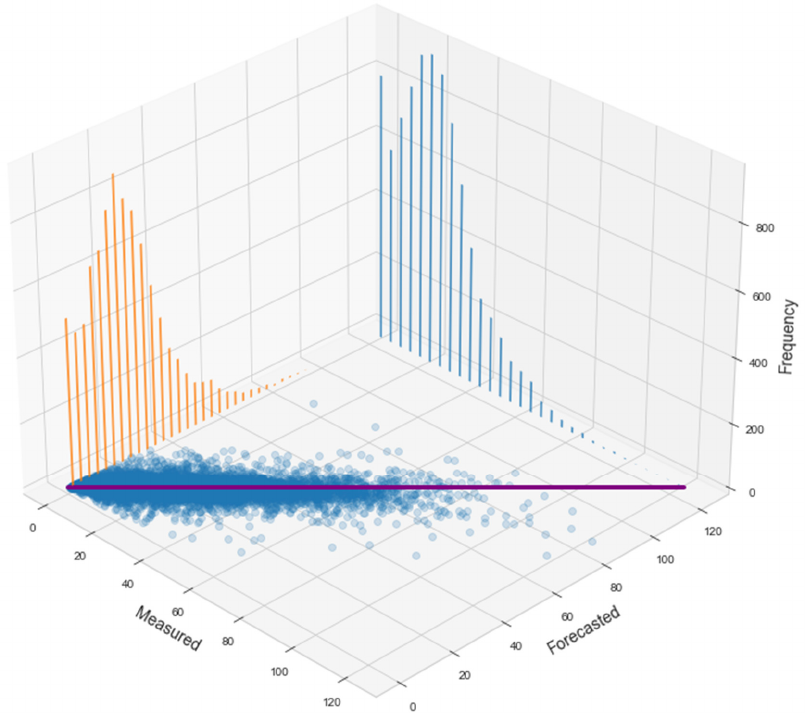
Figure 11. Scatter plot with marginal distribution for GraphSAGE model forecasting ozone 3 h ahead.